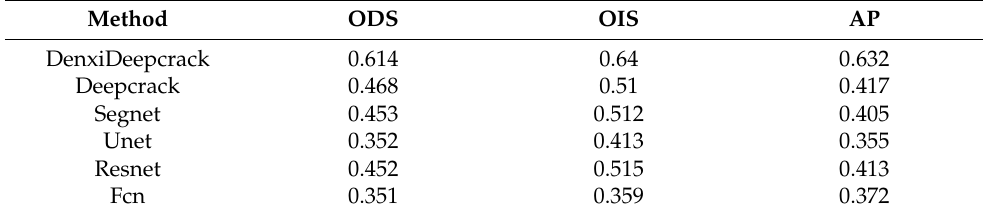
Table 5. Evaluation metrics of the six algorithms on the